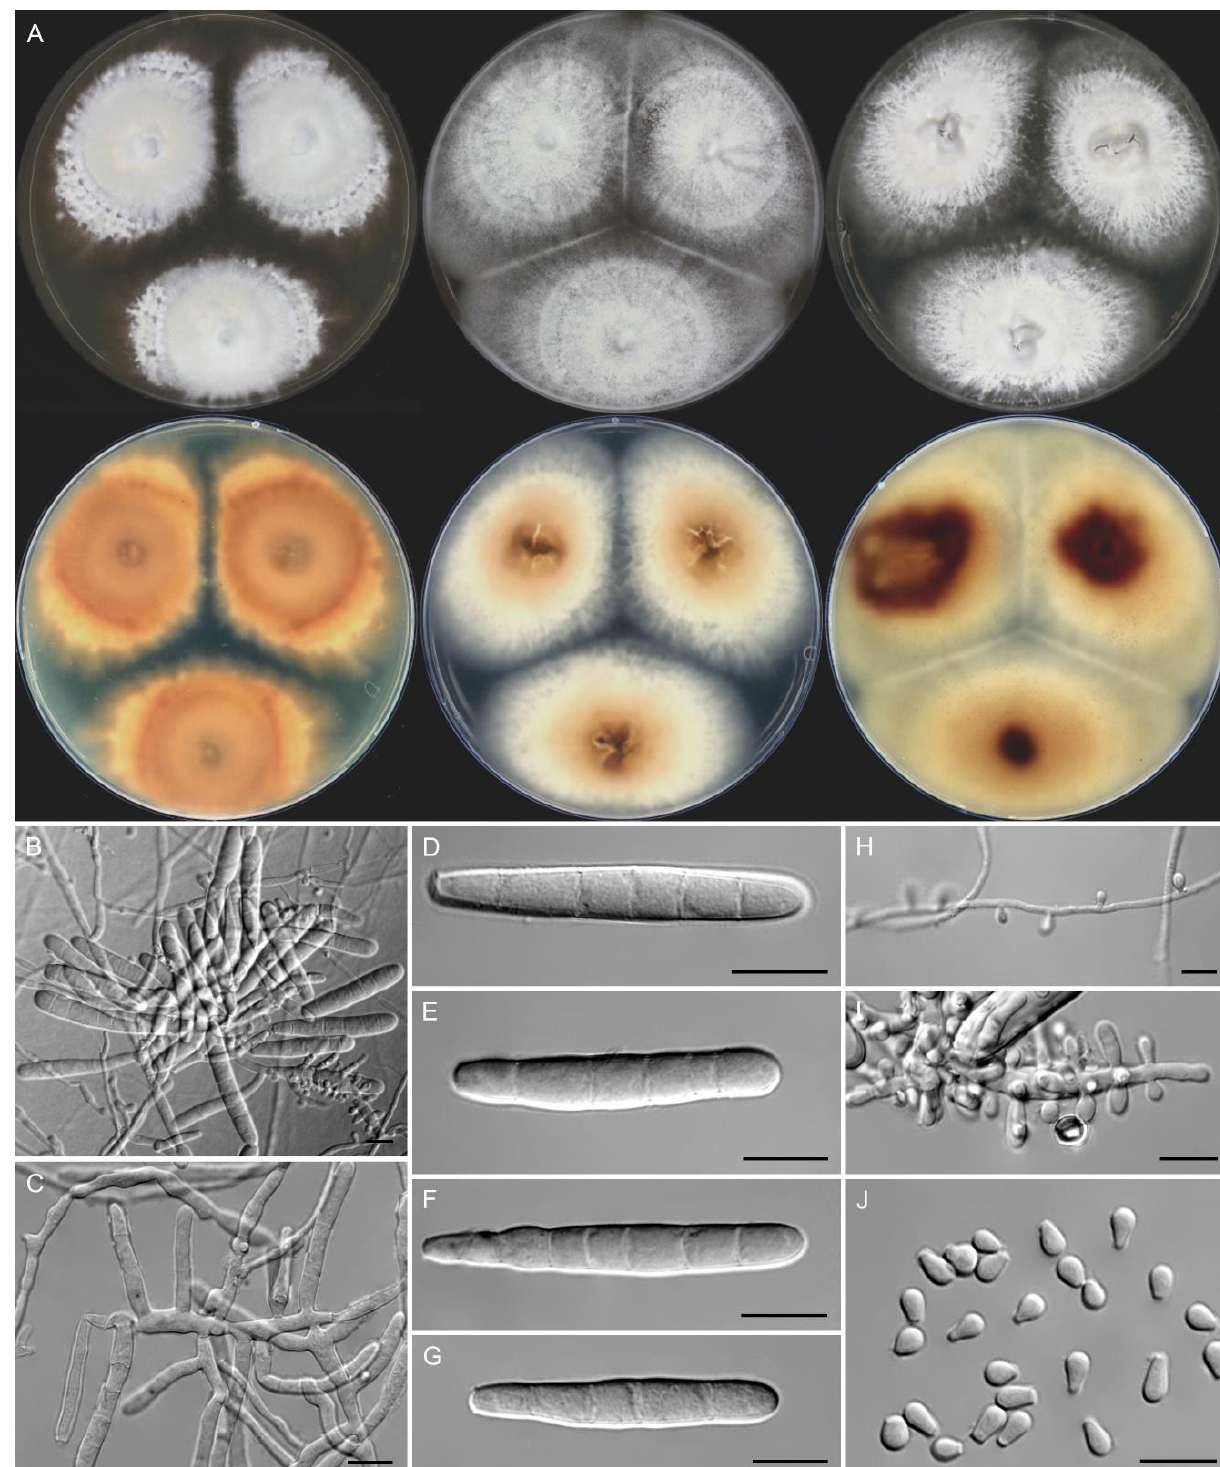
Figure 3. Macro- and micromorphology of Trichophyton quinckeanum . The obverse and reverse of colonies after two weeks of culture at 25 °C on Sabouraud dextrose agar, malt extract agar and potato dextrose agar ( A , from left to right); conidiophores bearing macroconidia ( B , C ); free macroconidia ( D – G ); conidiophores bearing microconidia ( H , I ); free microconidia ( J ). Scale bars = 10 µm.